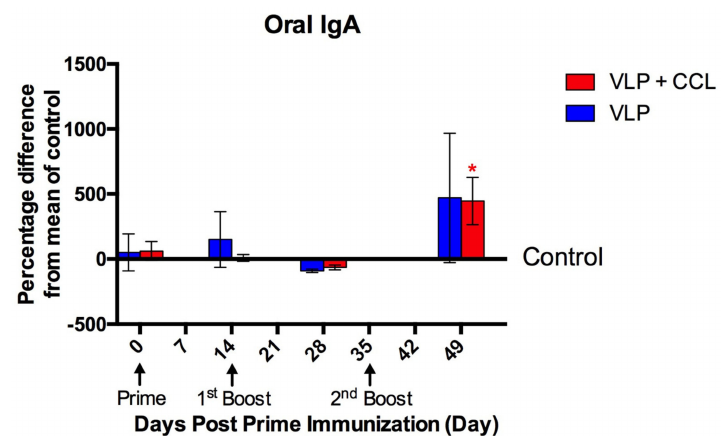
Figure 8. Oral PEDV S-specific IgA titers after the prime, 1st boost, and 2nd boost immunizations. Pigs were immunized at 0, 14, and 35 DPPI. Oral swabs were collected at day 0, 14, 28, and 49 DPPI to evaluate PEDV-specific IgA in the saliva by the PEDV S-based ELISA. The data are displayed as the percentage di ff erence from the mean of control, which is defined as the percentage di ff erence between treatment and control group divided by the mean of the control group, with SEM at di ff erent time points. The results of control, VLP, and VLP + CCL groups are presented as gray, blue, and red bars, respectively. The asterisk indicates the significant statistical di ff erence between treatment and control groups ( p < 0.05).